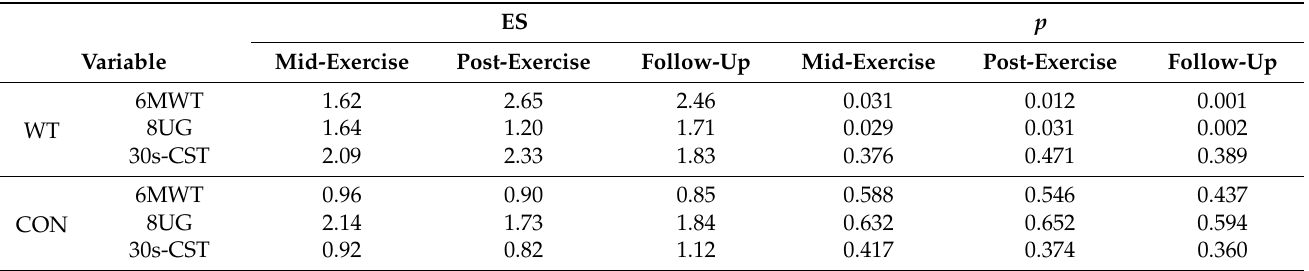
Table 5. The effect sizes and p -values of comparison of physical function fitness between different time points and baselines within the WT and CON groups. ES p